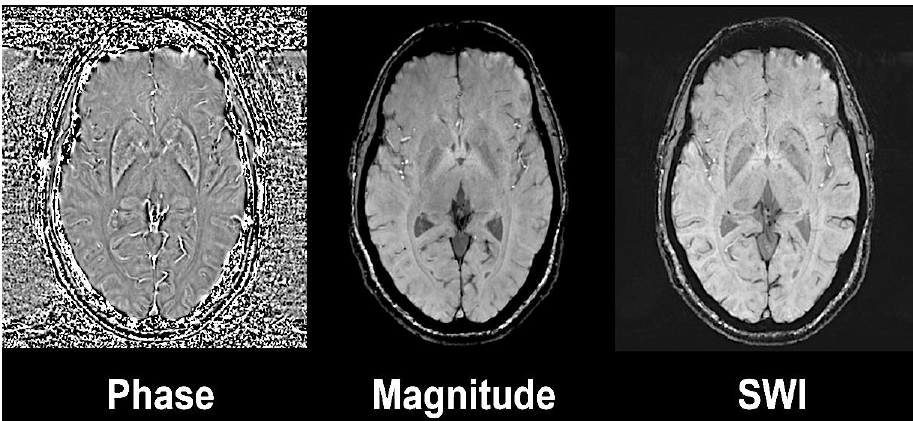
Figure 1. Susceptibility weighted image (left) is the result of the combination of high-pass filtered phase (left) and magnitude image (central). Axial slices at the level of basal ganglia on a 3 Tesla Siemens Magnetom Trio system with 32-channel phased-array head coil. Reprinted with the permission of [16].